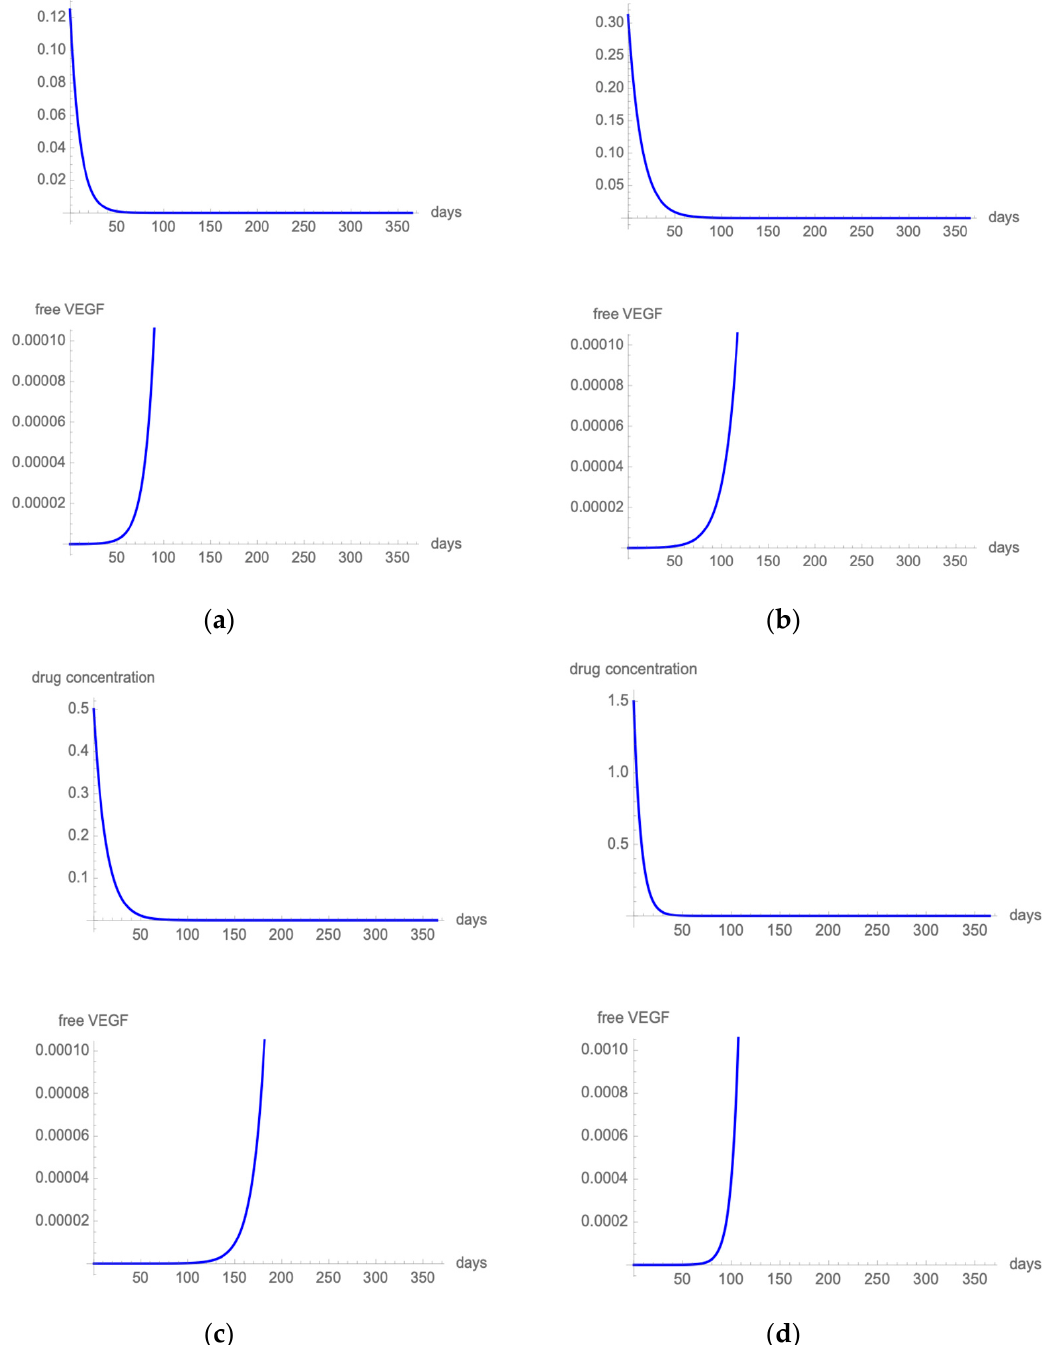
Figure 1. Figure 1 illustrates single-dose PK simulations after intravitreal dosing of 0.5 mg ranibi- zumab ( a ), 1.25 mg bevacizumab ( b ), 2 mg aflibercept ( c ), and 6 mg brolucizumab ( d ). In the upper